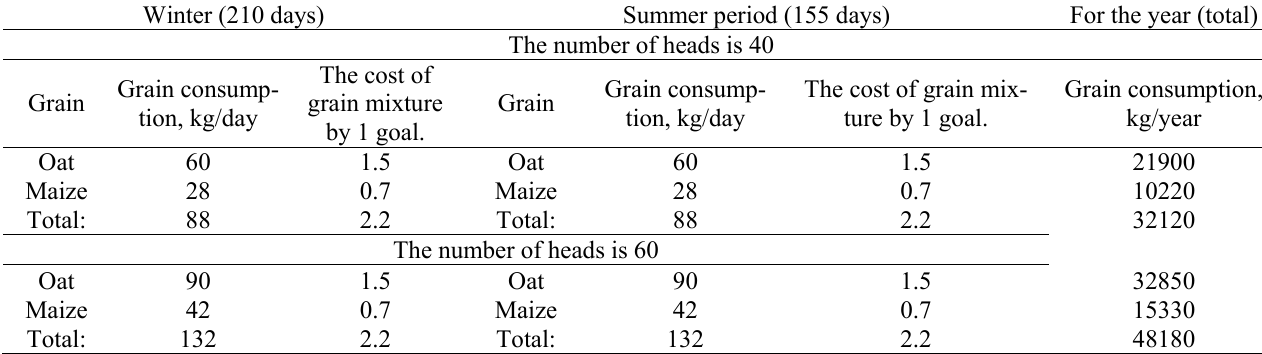
Volumes of grain mix required for feeding wild boar in the aviary of “Polisske-Sarny” Hunting Farm Winter (210